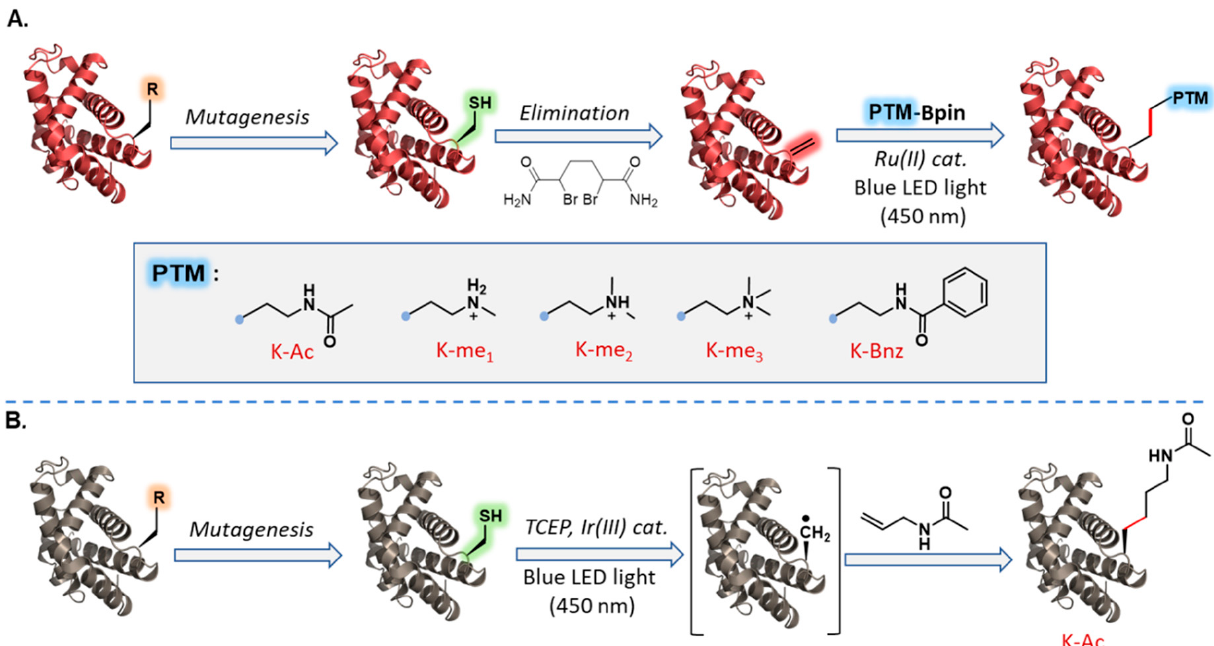
Figure 7. Chemical mutagenesis via visible-light-mediated carbon–carbon bond formation. ( A ) Chemoselective transfer of multiple Lys PTM mimics via Cys elimination followed by visible-light- driven Dha functionalization: mono-/di-/trimethylation, acetylation, and benzylation. ( B ) Chemose- lective transfer of native acetyl-Lys via visible-light-mediated desulfurative carbon–carbon bond formation